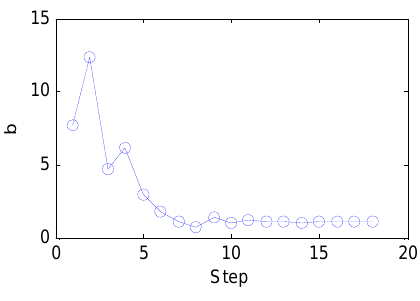
Figure 24. The curve of b versus step.